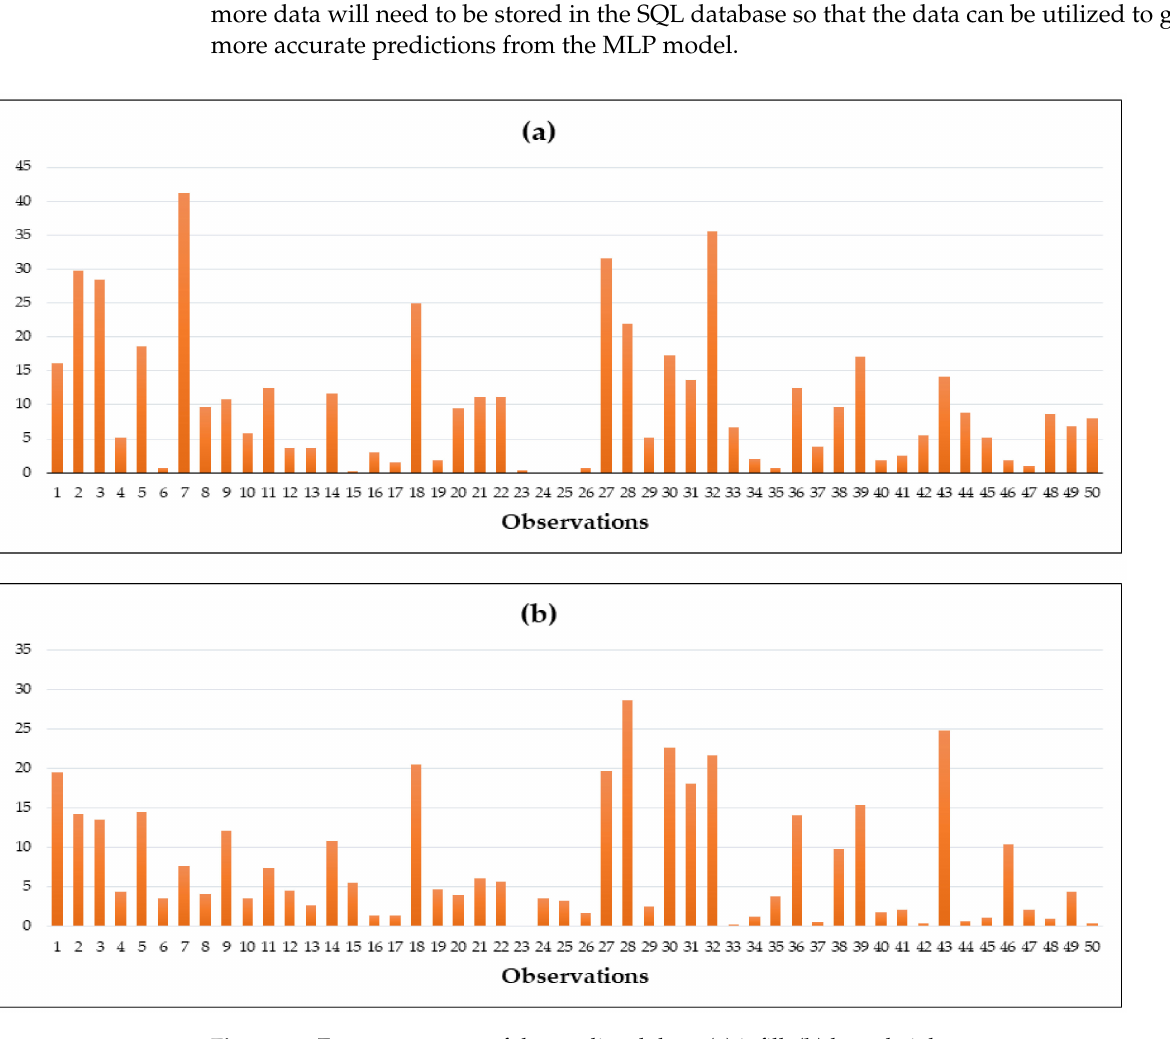
Figure 17. Error percentage of the predicted data: ( a ) infill; ( b ) layer